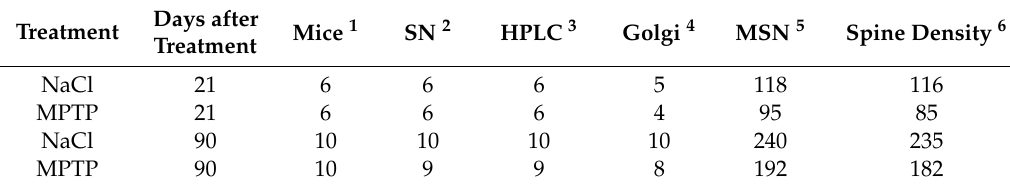
Table 1. Number of mice and MSN for morphological